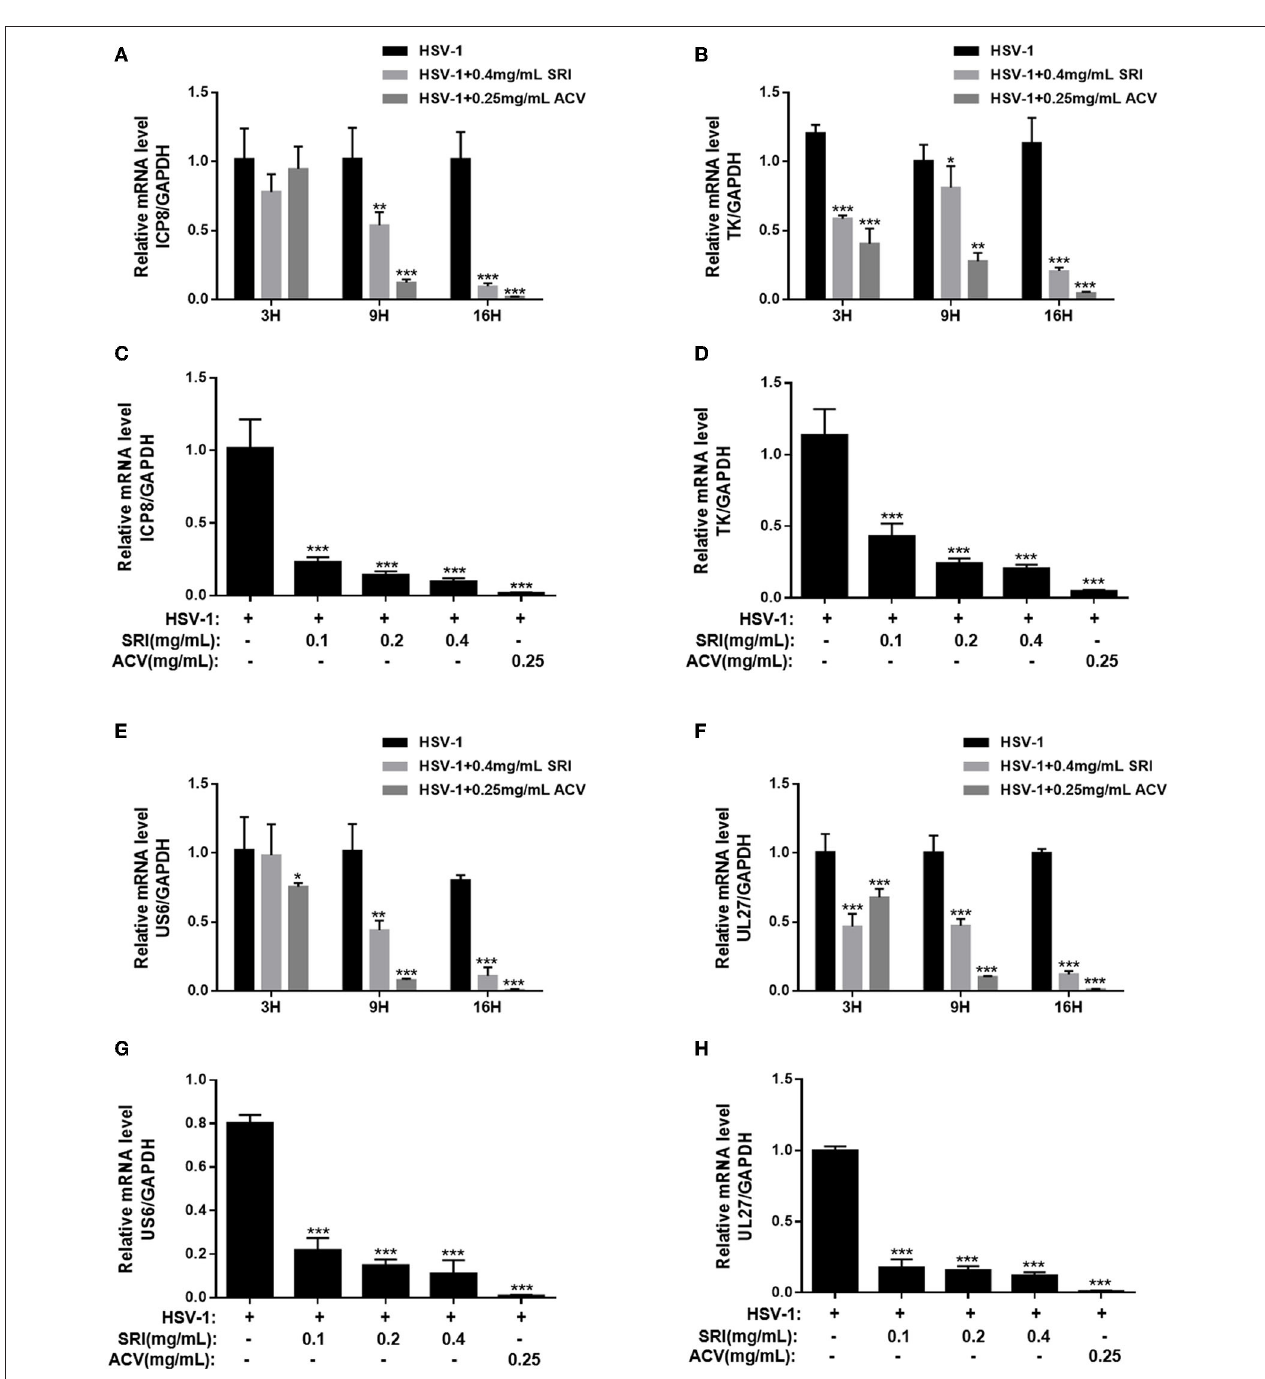
FIGURE 4 | Effect of SRI on HSV-1 E and L gene expression. ( A–H ) Confluent cells were infected with HSV-1 for 2h and then treated with the designated concentrations of SRI (0.05, 0.1, 0.2, and 0.4 mg/mL) or ACV (0.25 mg/mL). Total RNA was extracted at the indicated time points (3, 9, and 16h) and RT-PCR was employed to analyze the ICP8 (A) , TK (B) , US6 (E) , and UL27 (F) mRNA levels. The effects of SRI and ACV on ICP8, TK, US6, and UL27 genes of virus were determined after 16h (C,D,G,H) . The level of gene transcription was normalized by GAPDH. The data were presented as mean ± SD. * p < 0.05, ** p < 0.01, and *** p < 0.001, vs. HSV-1